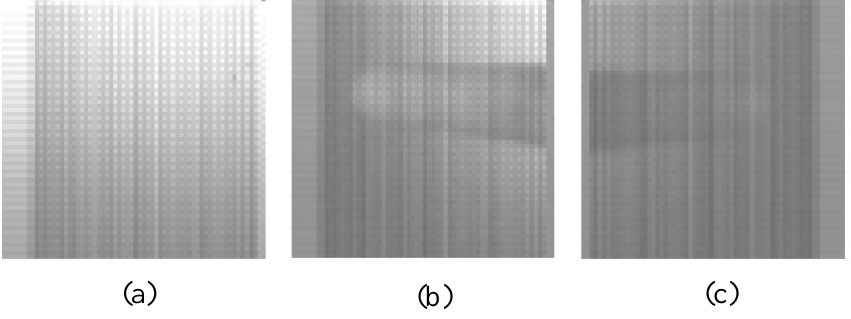
Figure 4. Sample captured images from the experimental set-up. ( a ) without any test object, ( b ) figertip when the incident light is unpolarized, and ( c ) fingertip when the incident light is 45 ◦